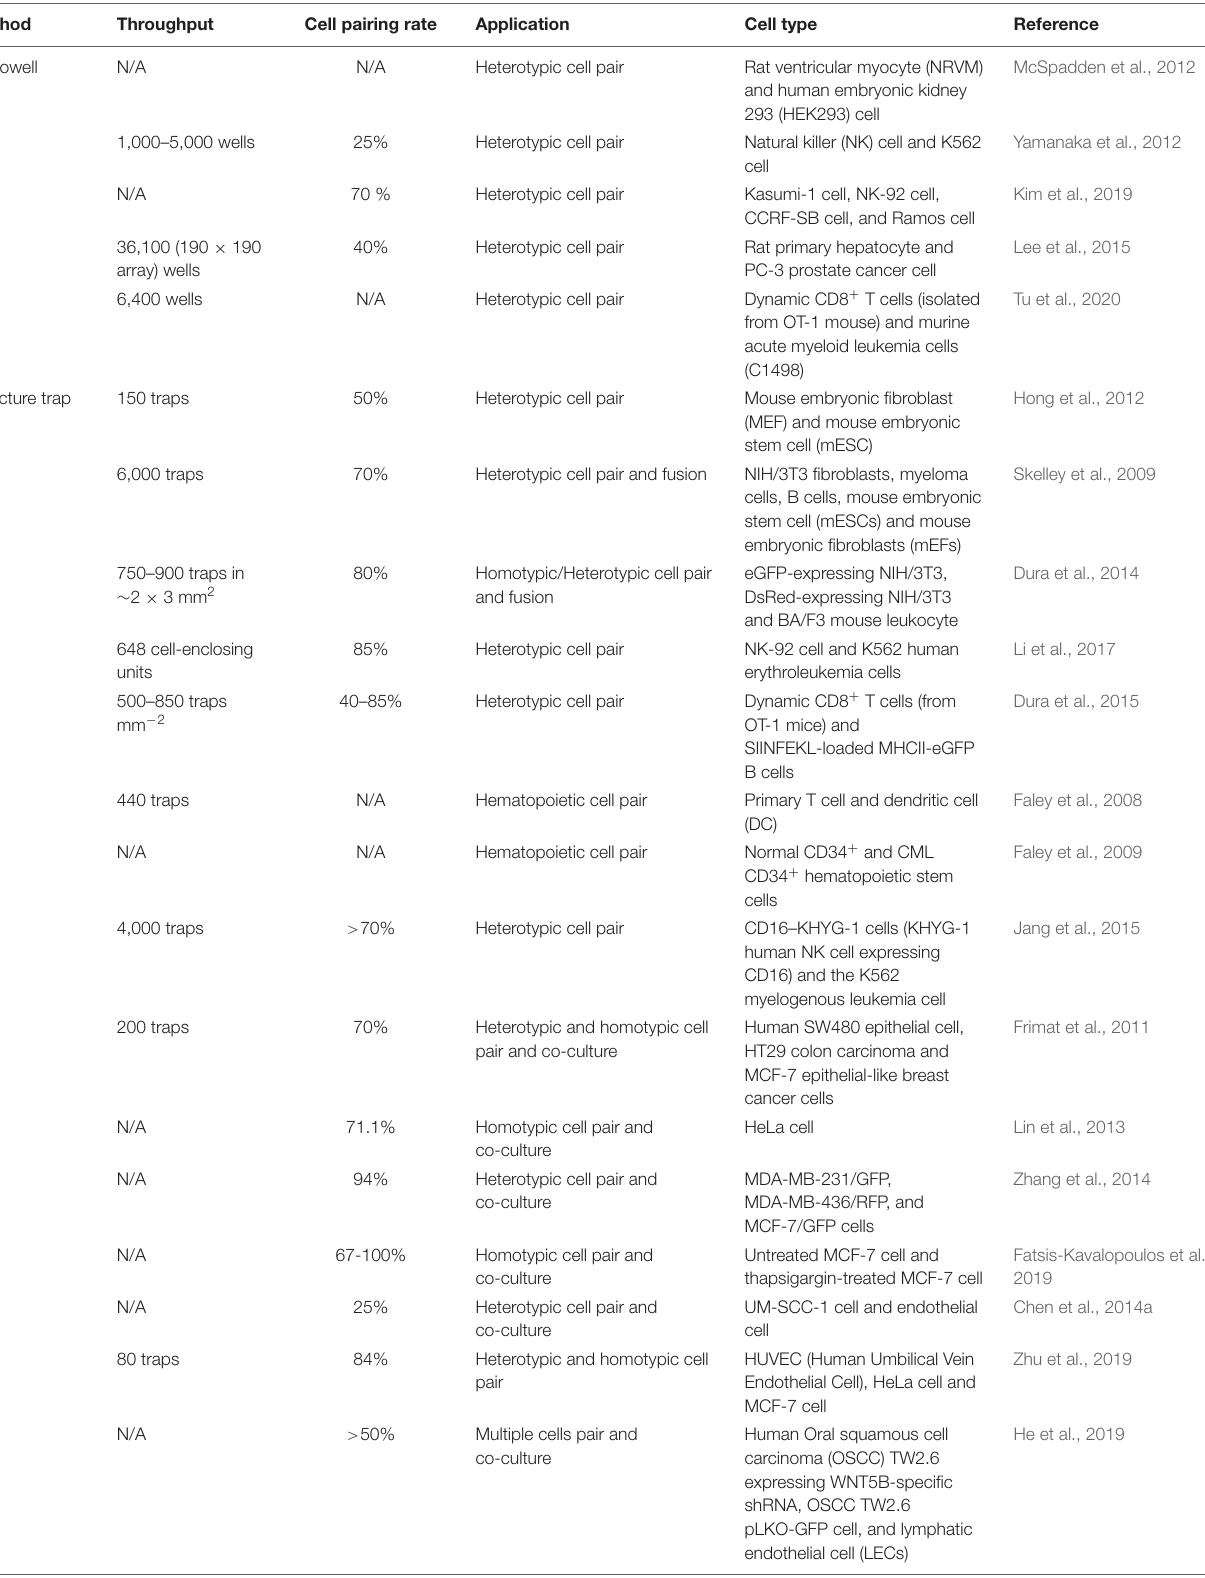
TABLE 1 | Microfluidic devices and their applications in 2D cell–cell